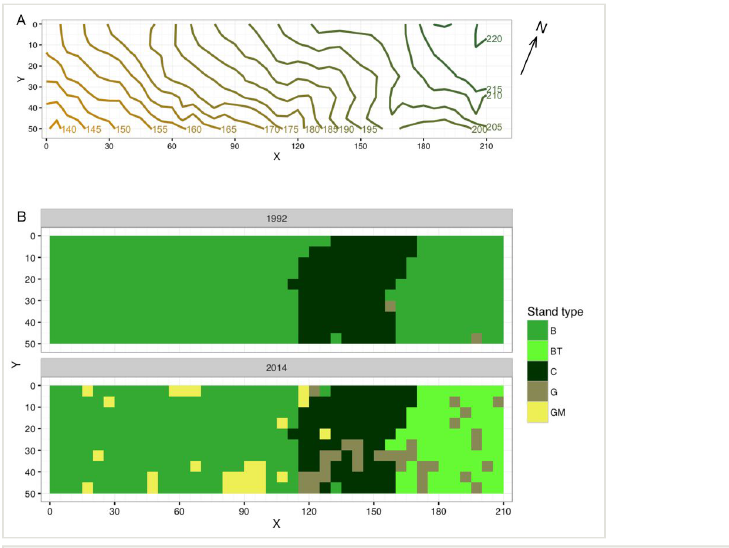
Figure 1. Outline of the study site. A) Contour map. B) Stand type. B: broadleaved, BT: broadleaved (thinned), C: conifer plantation, G: gap (not related to mass mortality of oak trees), GM: gap created or a ff ected by mass mortality of oak trees. A GM in the conifer plantation was generated by a dead oak stem that remained in the